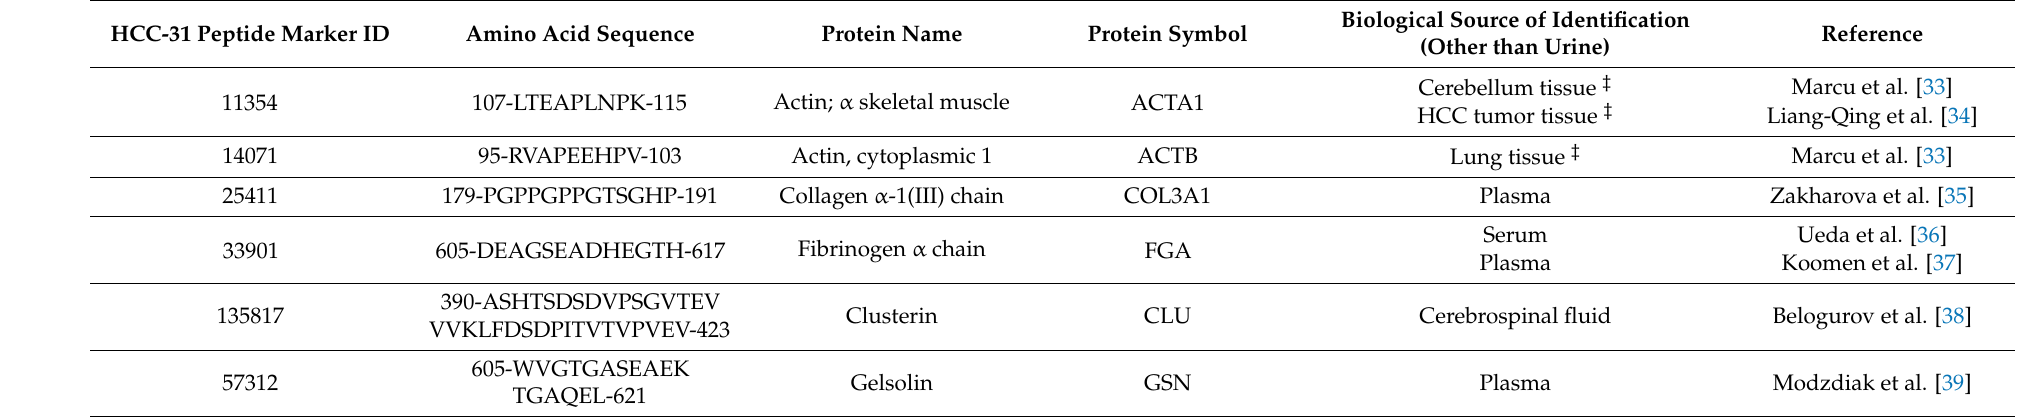
Table 6. List of HCC-31 peptide markers that were identified in human tissue or body fluids other than